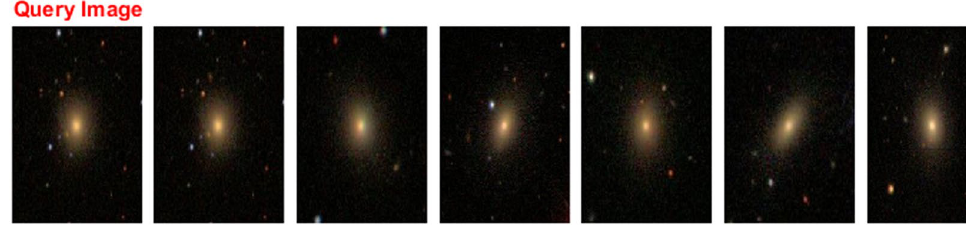
Figure 5. Galaxy image retrieval for an elliptical galaxy 29 .